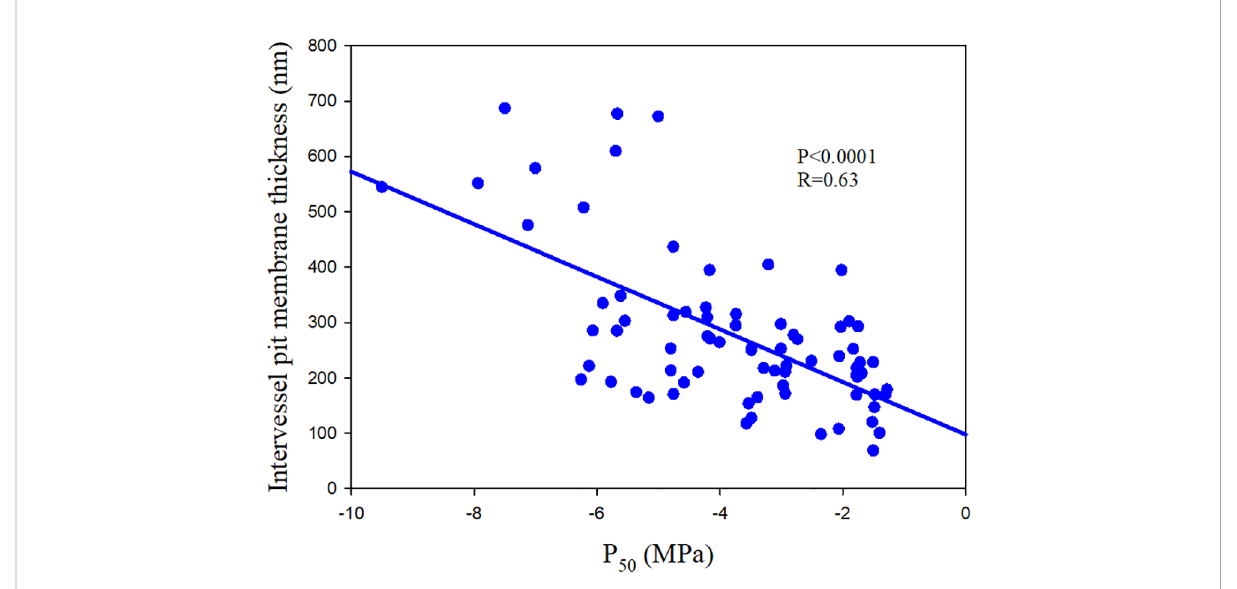
FIGURE 3 The relationship between water potential at which 50% loss of hydraulic conductance (P 50 ) and intervessel pit membrane thickness of 75 angiosperm speices. The data comes from Scholz et al. (2013); Kaack et al. (2021) and Li et al.